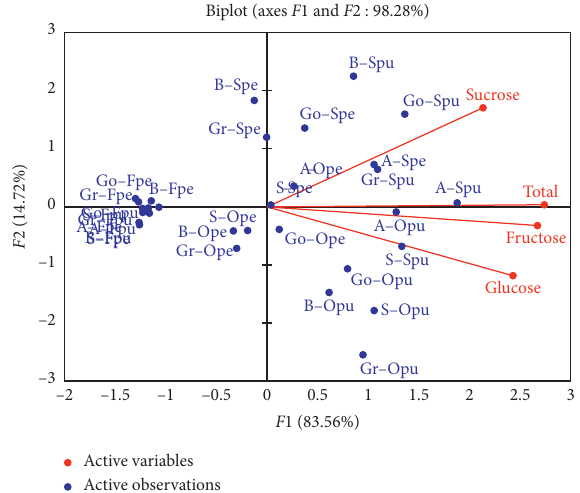
Figure 2: Biplot graph of sugars (scores and loading plots) ob- tained from principal component analysis (abbreviations; A-Fpe: Amasya fresh peel; A-Fpu: Amasya fresh pulp; A-Ope: Amasya oven-dried peel; A-Opu: Amasya oven-dried pulp; A-Spe: Amasya sun-dried peel; A-Spu: Amasya sun-dried pulp; B: Braeburn; Go: Golden Delicious; Gr: Granny Smith; S: